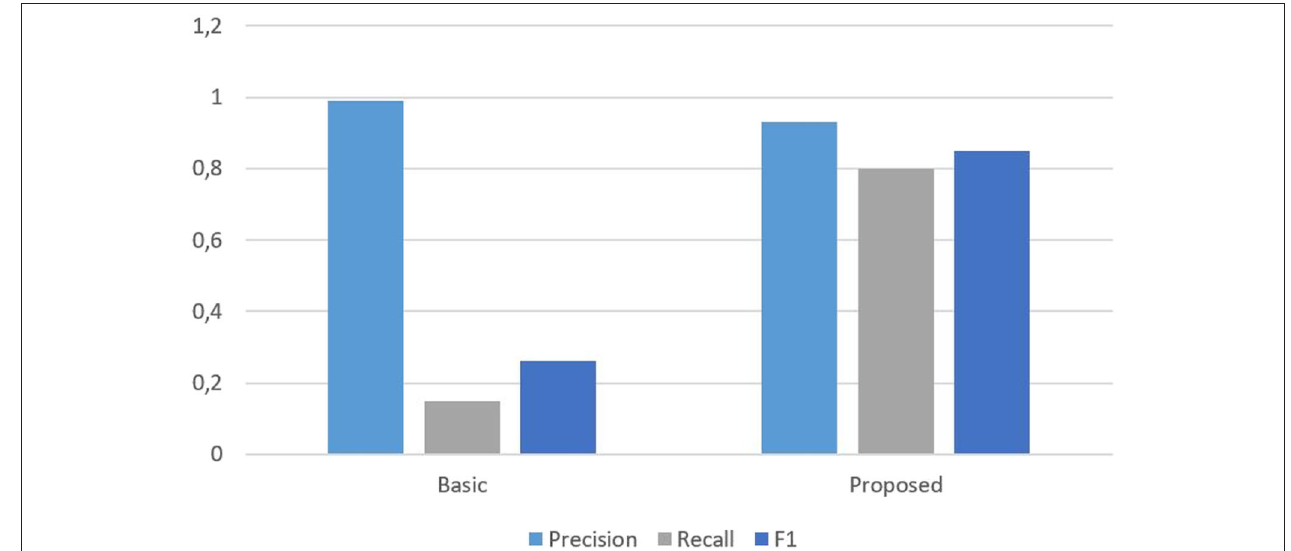
FIGURE 4 | Results of “basic” and “proposed” methods from article (Kuznecova et al.,